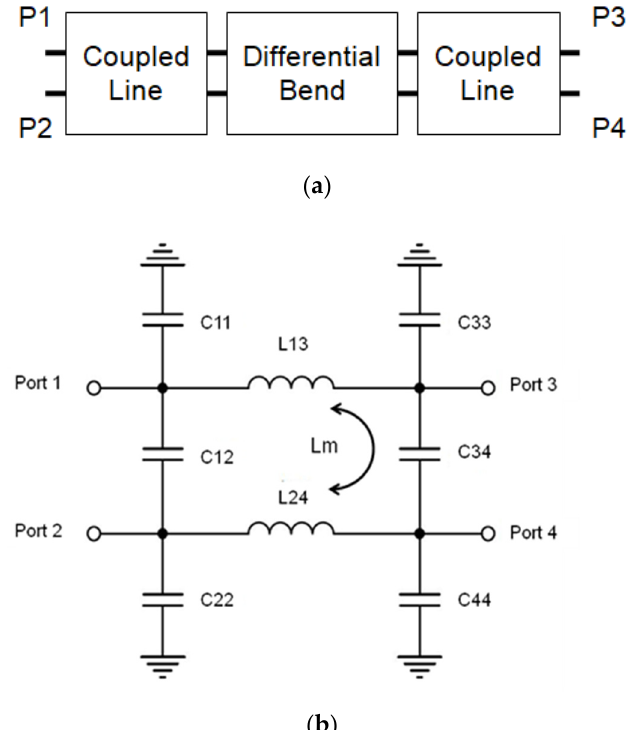
Figure 6. ( a ) Block diagram of a lumped circuit, ( b ) lumped equivalent circuit model of the differential bend.